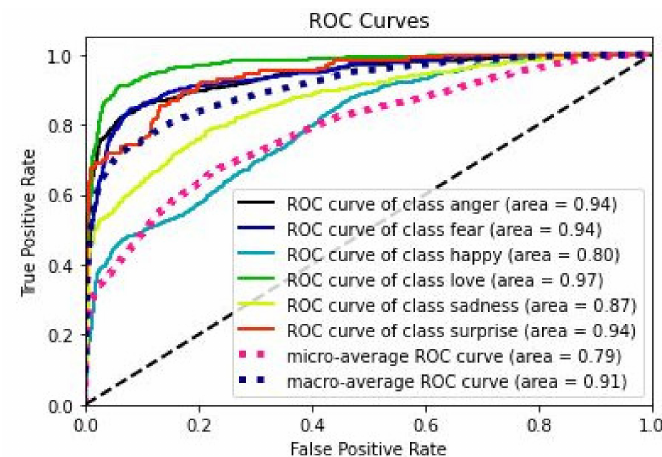
Figure 5. SVC ROC—emotions